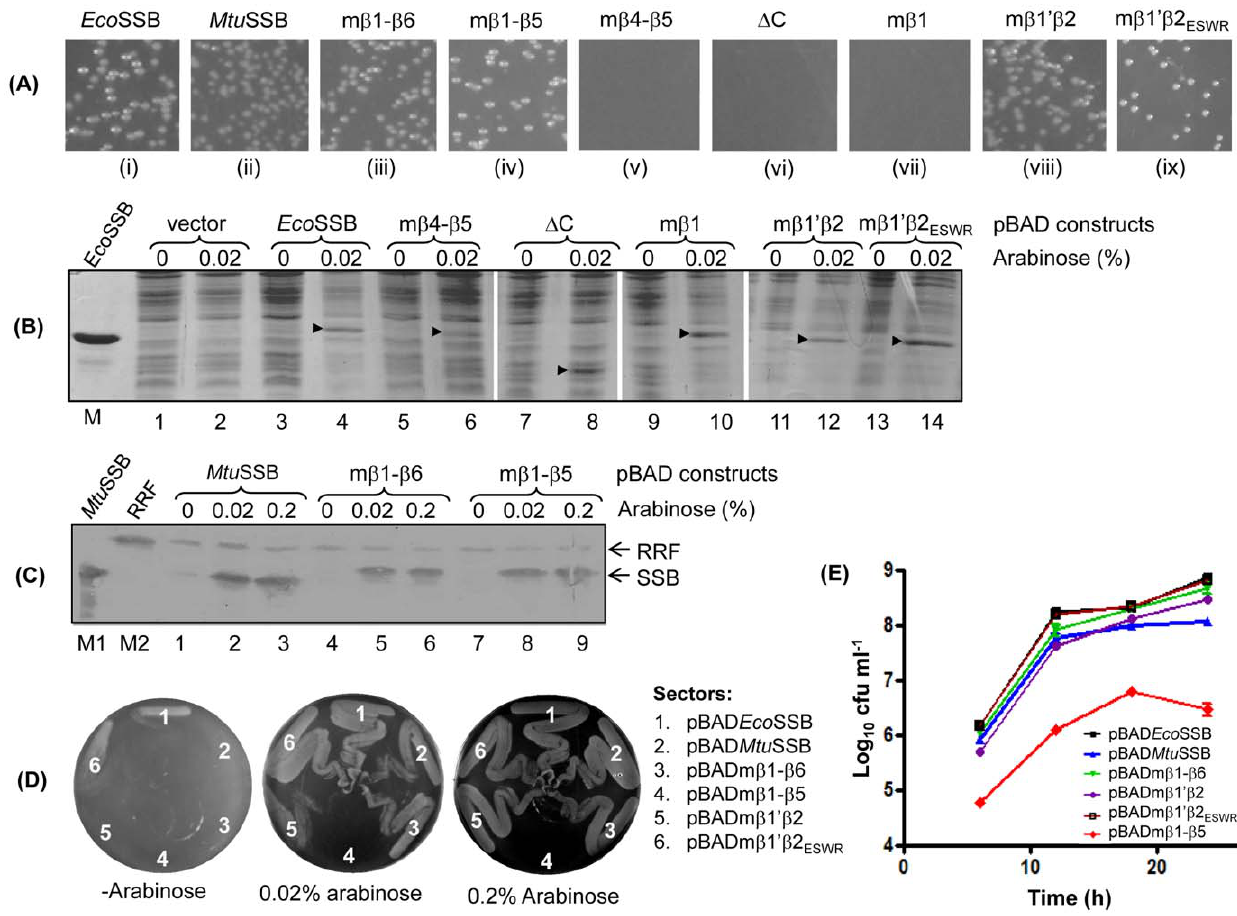
Figure 6. Functional analysis of SSBs. ( A ) Transformants of chimeric SSB constructs in E. coli RDP 317-1 in the presence of 0.02% arabinose (and absence of IPTG). Panels: (i) pBAD Eco SSB, (ii) pBAD Mtu SSB, (iii) pBADm b 1– b 6, (iv) pBADm b 1– b 5, (v) pBADm b 4– b 5, (vi) pBAD D C, (vii) pBADm b 1, (viii) pBADm b 1 9 b 2, and (ix) pBADm b 1 9 b 2 ESWR . ( B ) Expression analysis of SSBs in E. coli TG1. SDS-PAGE analysis of 10 m g total cell proteins of the transformants harboring SSB constructs as indicated on top of the gel. ( C ) Immunoblot analysis of 10 m g total cell proteins of transformants as indicated on top of the blot using antibodies against Mtu SSB and Eco RRF (host protein used as loading control). Lane M, is the marker lane containing 80 ng and 180 ng of Mtu SSB and Eco RRF, respectively. ( D ) Streaking of the overnight cultures of the various transformants obtained in panel ( A ) on LB-agar containing Kan, Amp and arabinose (0.0–0.2%) and incubated at 37 u C for , 12 h. Sectors: 1, pBAD Eco SSB; 2, pBAD Mtu SSB; 3, pBADm b 1– b 6; 4, pBADm b 1– b 5; 5, pBADm b 1 9 b 2; and 6, pBADm b 1 9 b 2 ESWR ( E ) Cell viability of RDP 371-1 supported with various SSB constructs. Colony forming units (cfu) were determined at 6, 12, 18 and 24 h of the culture growth.